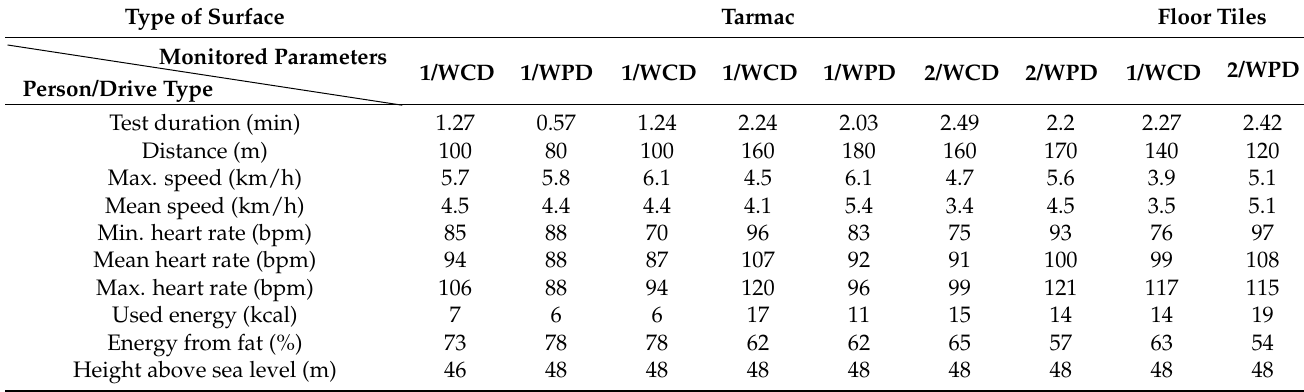
Table 1. Results of field